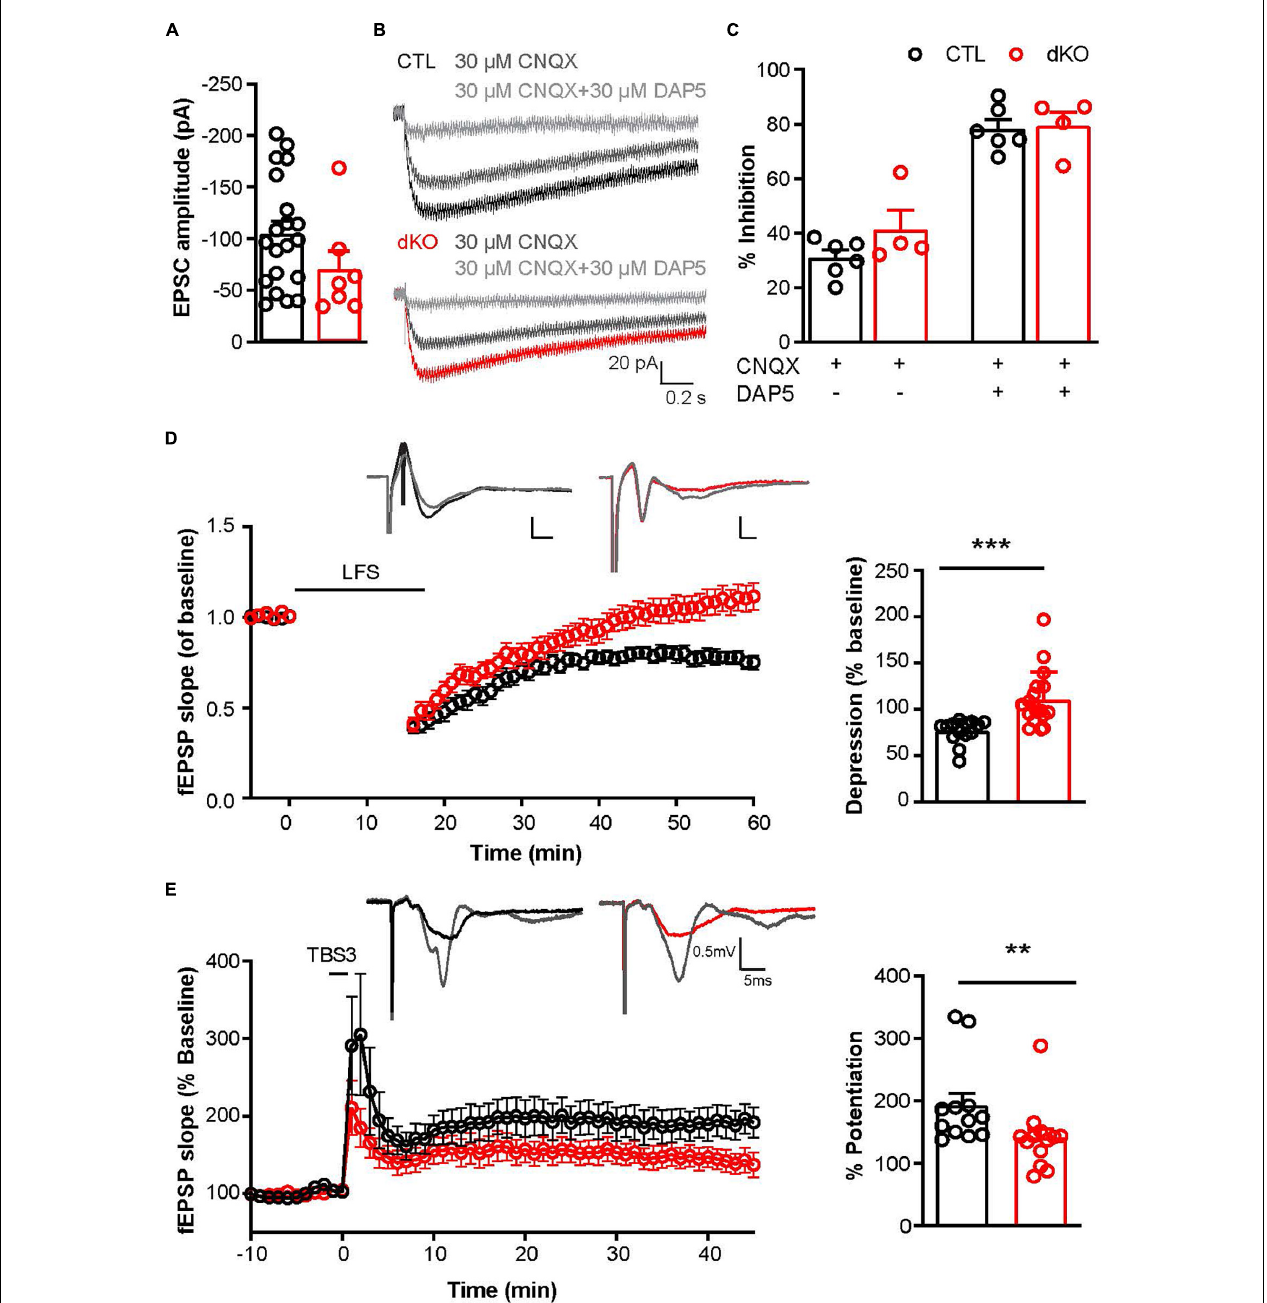
FIGURE 4 | Functional consequences of the conditional L-type VGCCs gene ablation for NG2 glia-neuron interaction and synaptic plasticity. (A) Evoked excitatory postsynaptic currents (EPSCs) in cortical NG2 glia of CTL and dKO mice. (B) EPSC amplitudes of CTL and dKO mice. (C) Inhibition of EPSCs in CTL and dKO mice by antagonists of AMPARs and NMDARs. Each datapoint represents data obtained from a single NG2 glial cell. (D) Long-term depression (LTD) evoked by low-frequency stimulation (LFS) could be elicited in controls, but not in dKO mice. Each datapoint represents recordings from a single slice. More than three mice per group were analyzed. Scale bar, x = 2 ms, y = 0.5 mV. (E) Long-term potentiation (LTP) evoked by triple θ -burst stimulation (TBS3) in dKO mice were significantly decreased compared to controls. Scale bar, x = 5 ms, y = 0.5 mV. ** p < 0.01; *** p <